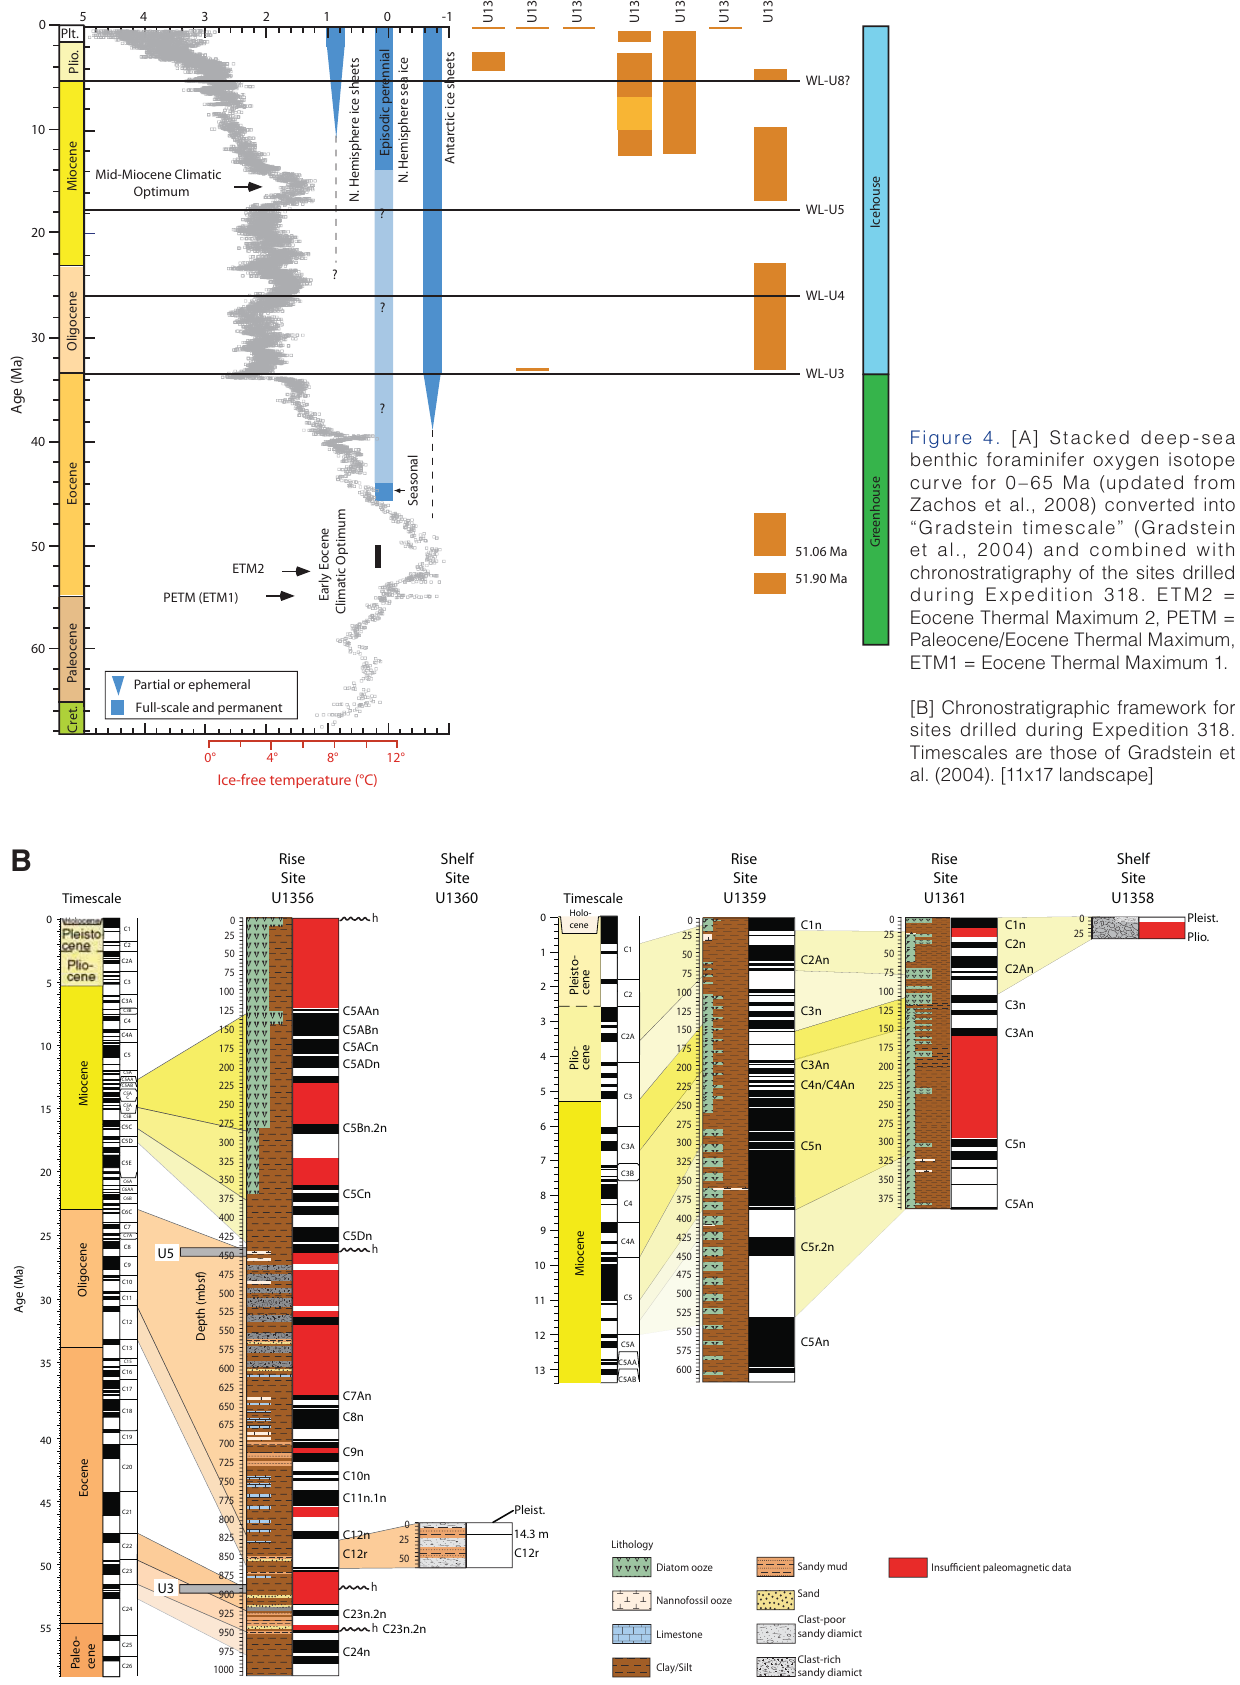
Figure 4. [A] Stacked deep-sea benthic foraminifer oxygen isotope curve for 0–65 Ma (updated from Zachos et al., 2008) converted into “Gradstein timescale” (Gradstein et al., 2004) and combined with chronostratigraphy of the sites drilled during Expedition 318. ETM2 = Eocene Thermal Maximum 2, PETM = Paleocene/Eocene Thermal Maximum, ETM1 = Eocene Thermal Maximum 1. [B] Chronostratigraphic framework for sites drilled during Expedition 318. Timescales are those of Gradstein et al. (2004). [11x17